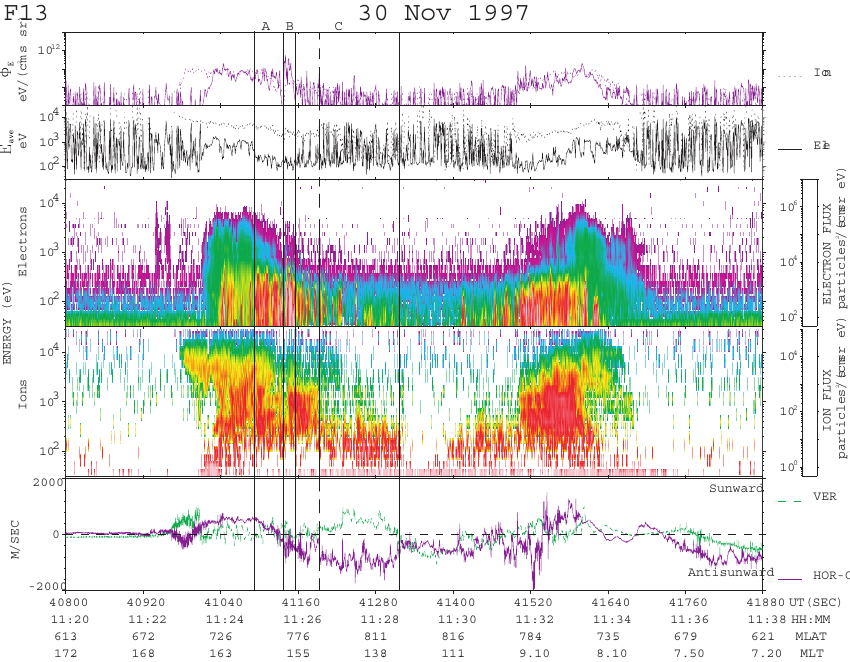
Fig. 5. DMSP F13 particle precipitation and ion drift data for the interval 11:20–11:38 UT. Panels from top to bottom show: (i) energy flux for electrons and ions (dotted), (ii) average energy of electrons and ions (dotted), (iii) electron and (iv) ion differential fluxes (color-coded according to scale to the right), and (v) horizontally across-track (violet) and vertical (green) ionospheric ion drift components. Different latitude regimes of discrete auroral precipitation on the dusk side are marked by vertical